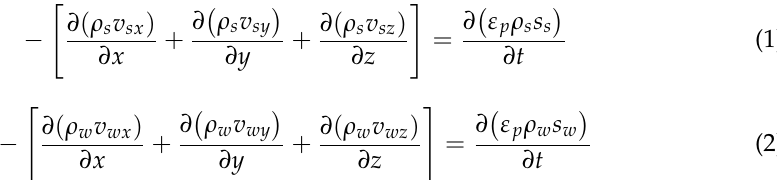
Figure 8. Numerical model of small bed separation slurry transport. The model is calculated by the two-phase Darcy’s law. The model assumes that the separation position will not change after the separation space is filled with grout; the slurry is an incompressible homogeneous isotropic fluid; the model medium is isotropic and incompressible, and the permeability remains constant; and the coexistence space of groundwater and slurry is regarded as Darcy’s law two-phase seepage field. After simplification, the seepage direction of groundwater remains uniform, and the pressure is constant. The control equation of the model is composed of a dynamic equation, mass conservation equation, and fracture seepage equation, as shown in Equations (1)–(6). The mass conservation equation of slurry is shown in Equation (1). The mass conser- vation equation of water is shown in Equation (2).